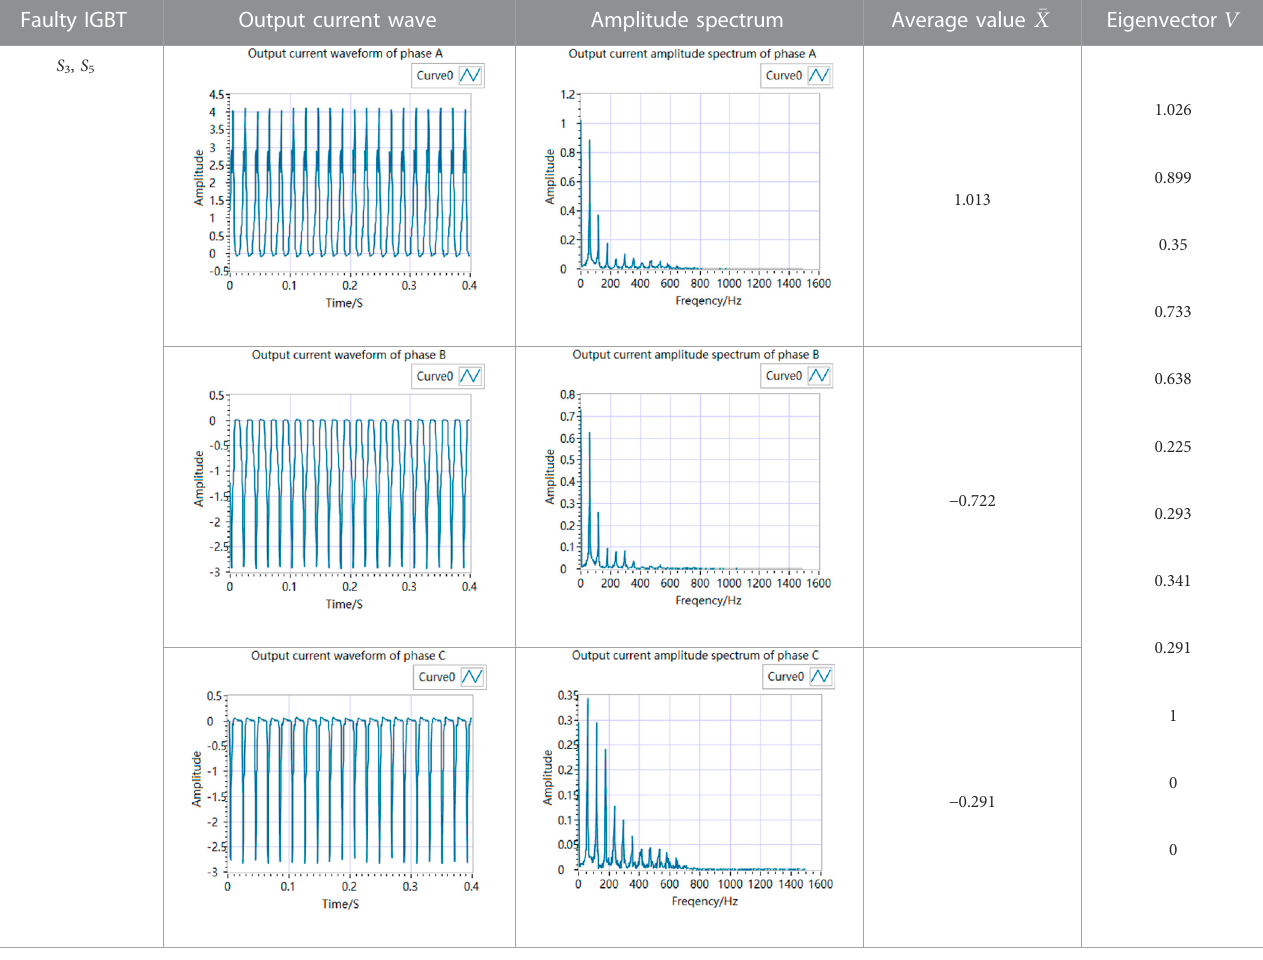
TABLE 3 Fault eigenvector and amplitude spectra of phase A, B, and C with S 3 and S 5 failure simultaneously. Faulty